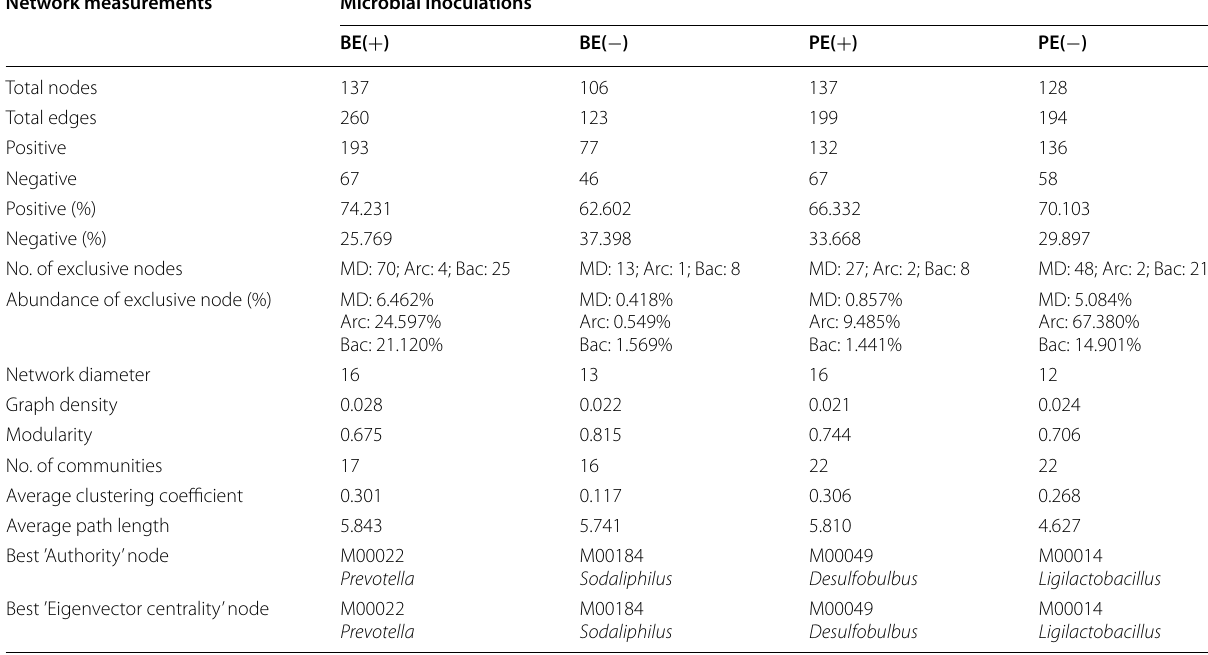
BE, bacterial-enriched rumen fluid; PE, protozoal-enriched rumen fluid; MD, KEGG modules; Arc, archaeal genera; Bac, bacterial genera